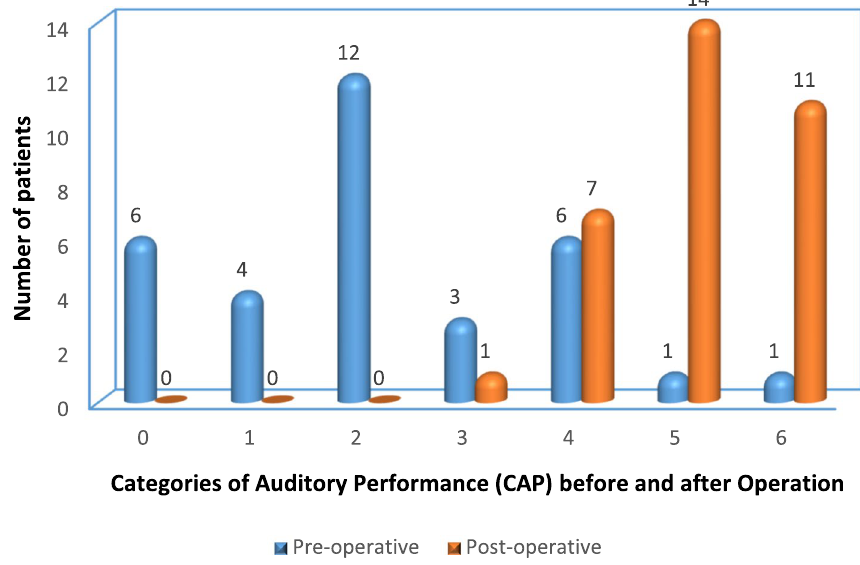
Fig. 3 Comparison of Categories of Auditory Performance (CAP) before and after